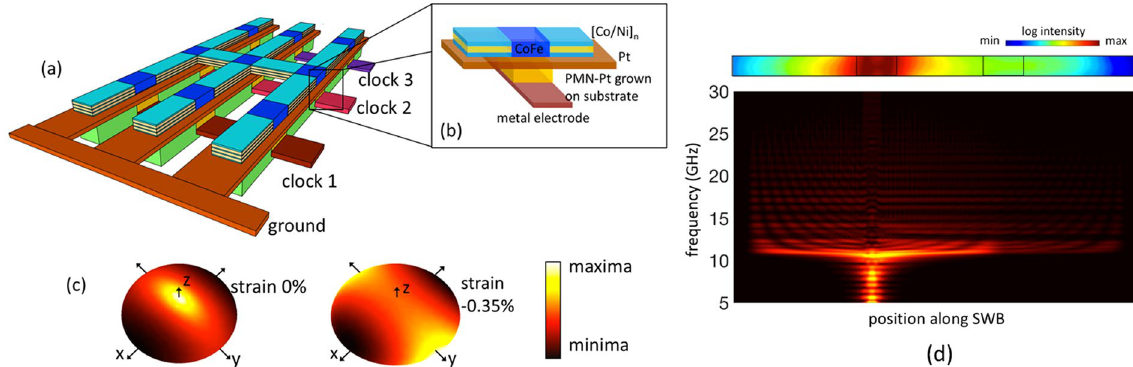
Figure 2. ( a ) Illustration of a possible layout of a spin wave logic circuit, ( b ) Details of the main building blocks - ME cell and PMA SWB. The ferroelectric PMN-PT is assumed to be epitaxially grown on an appropriate substrate in order to produce a small built-in strain. ( c ) Energy landscape of the CoFe layer of the ME cell under the case of 0 and − 0.35% built-in strain. ( d ) Spin wave transmission from the transmitter ME cell through the SWB to the detector ME cell and the frequency spectra along the length of the SWB, obtained from FFT of the x -component of the